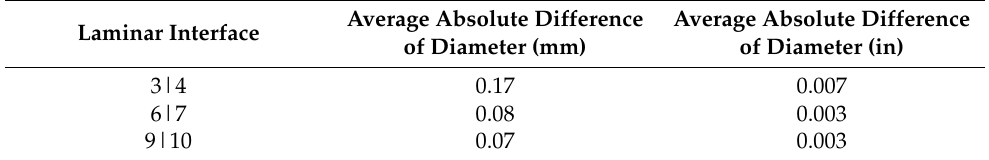
Table 4. Error in diameter as a function of depth using MGT.